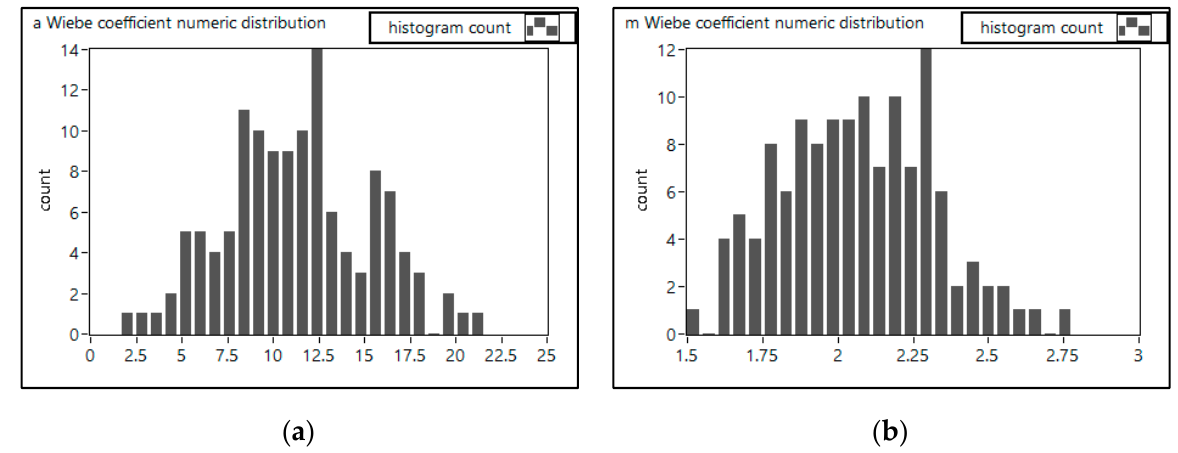
Figure 14. Histograms of Wiebe coefficients numeric distribution; MAP = 1 bar, n = 3500 rpm, fuel NG. ( a ) a coefficient (mean value = 11.2, SD = 3.93); ( b ) m coefficient (mean value = 2.08, SD = 0.254). Figure 15a,b report the 100 consecutive pressure curves obtained by the 0-D simulation model described in [11] using the Hill and Wiebe equations, respectively.